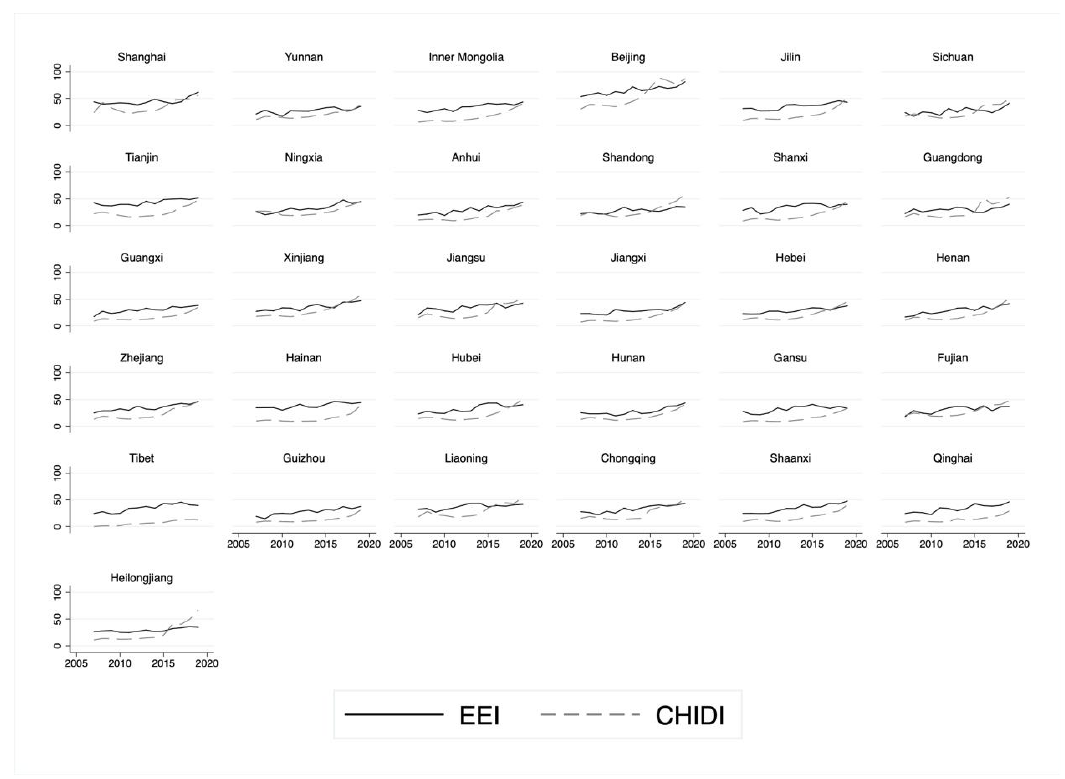
Figure 2. EEI of each region from 2007 to 2019. Note: The above figure is the estimated data, and the original data comes from the China Statistical Yearbook over the years.